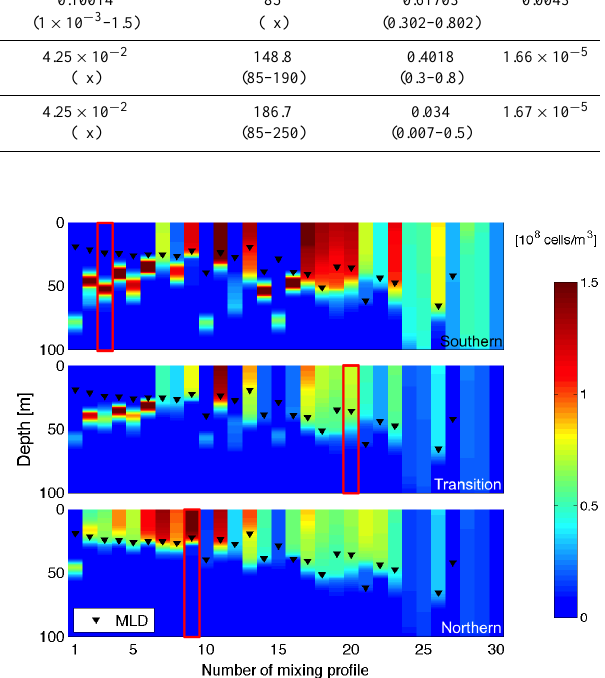
Table 3. Description of the reference stations with the boundary conditions for the bottom nutrient concentration N b and the incoming light Fig. 9: Measured vertical mixing profiles aligned accord- intensity I in as well as the biological parameters calibrated with the LSM. Numbers in parentheses give the range of values tested during the ing to the mean mixing strength with increasing strength calibration. along the x-axis as shown in the lower graph (logarithmic y-axis).The red boxes indicate the vertical mixing used for the model calibration at the southern, northern and transition station (left to right).